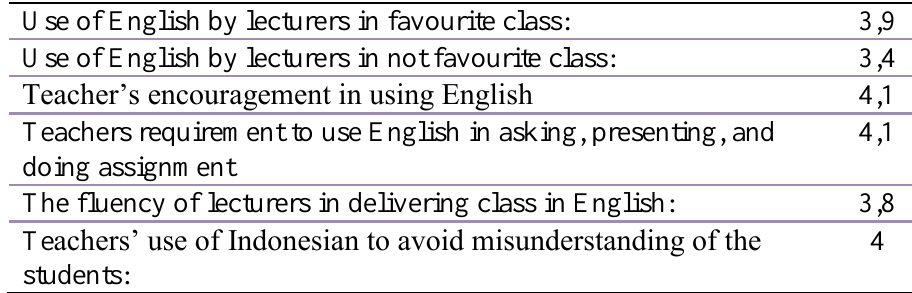
Table 6. Lecturers’ Use of English in Classroom Interaction